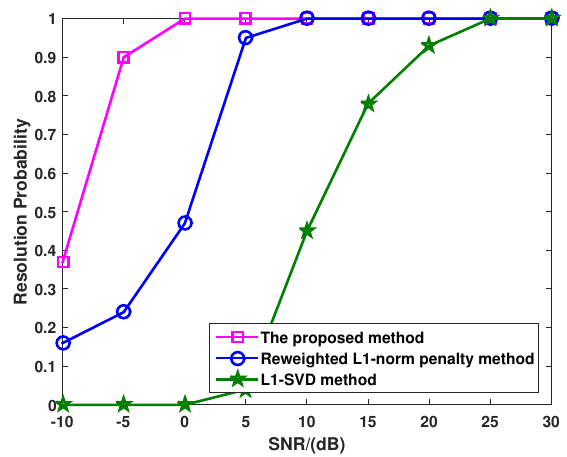
Figure 5. Target resolution probability of the l 1 -SVD method, the reweighted l 1 -norm penalty method and the proposed method when the SNR varies from − 10 dB to 30